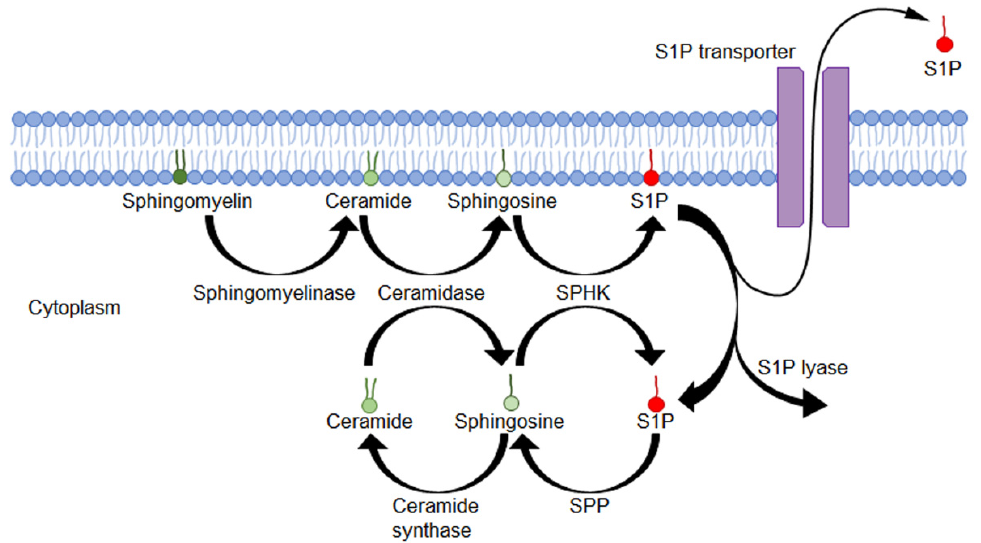
Figure 1. Biosynthesis and metabolic pathways of sphingolipids. Sphingomyelin in the lipid bilayer is converted to ceramide by sphingomyelinase. Ceramide is transformed into sphingosine by ceramidase. Some sphingosines are phosphorylated by sphingosine kinase (SPHK) and converted to the bioactive lipid S1P. S1P is either released in extracellular space via S1P transporters, degraded by S1P lyase, or transformed by sphingosine phosphatase (SPP) to sphingosine. Plasma S1P concentrations are high in the μ M order [18], but most of it is bound to albumin and high-density lipoprotein (HDL), resulting in low levels of free S1P (less than 2%) [19]. In contrast, the concentration of S1P in the stromal fluid is considered to be